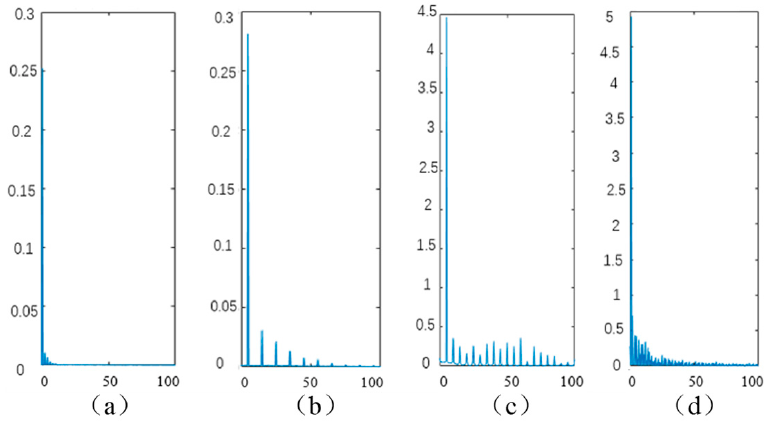
Figure 13. Variation of power spectral density: ( a ) f = 1 Hz; ( b ) f = 3 Hz; ( c ) f = 5 Hz; ( d ) f = 10 Hz.